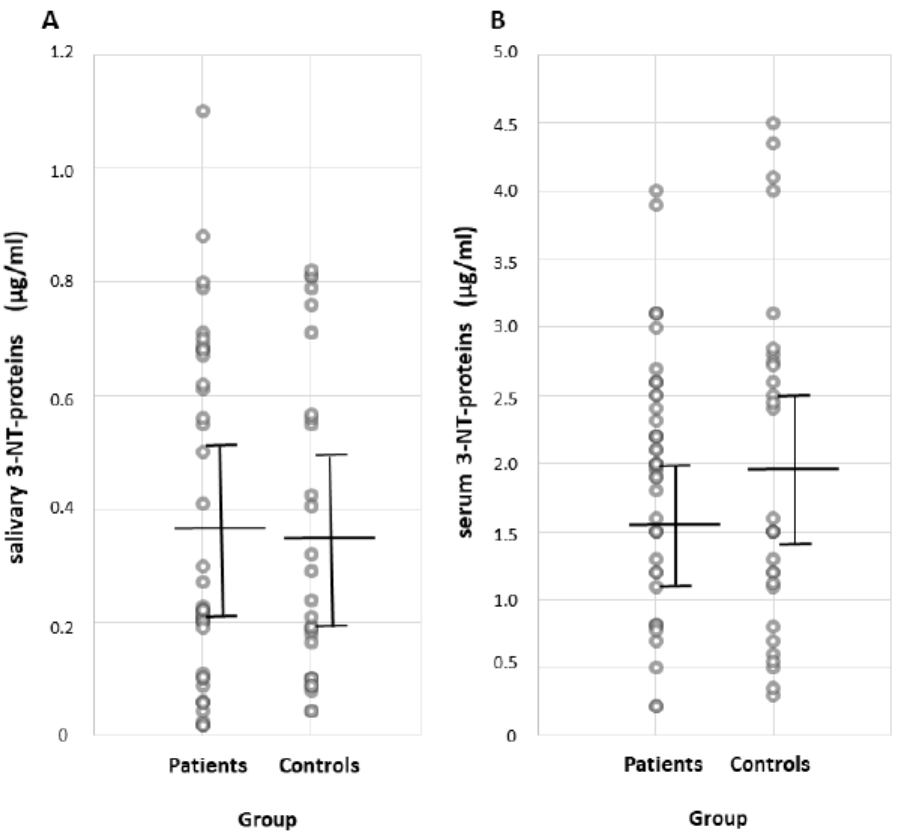
Figure 2. Individual 3-NT-proteins concentration ( µ g/mL) in ( A ) saliva and ( B ) serum in patients with IPD and control participants, as measured with ELISA. Mean and standard deviation are represented with solid lines. Abbrev.: 3-NT-proteins, 3-nitrotyrosine proteins; IPD, idiopathic Parkinson’s disease; ELISA, enzyme-linked immunosorbent